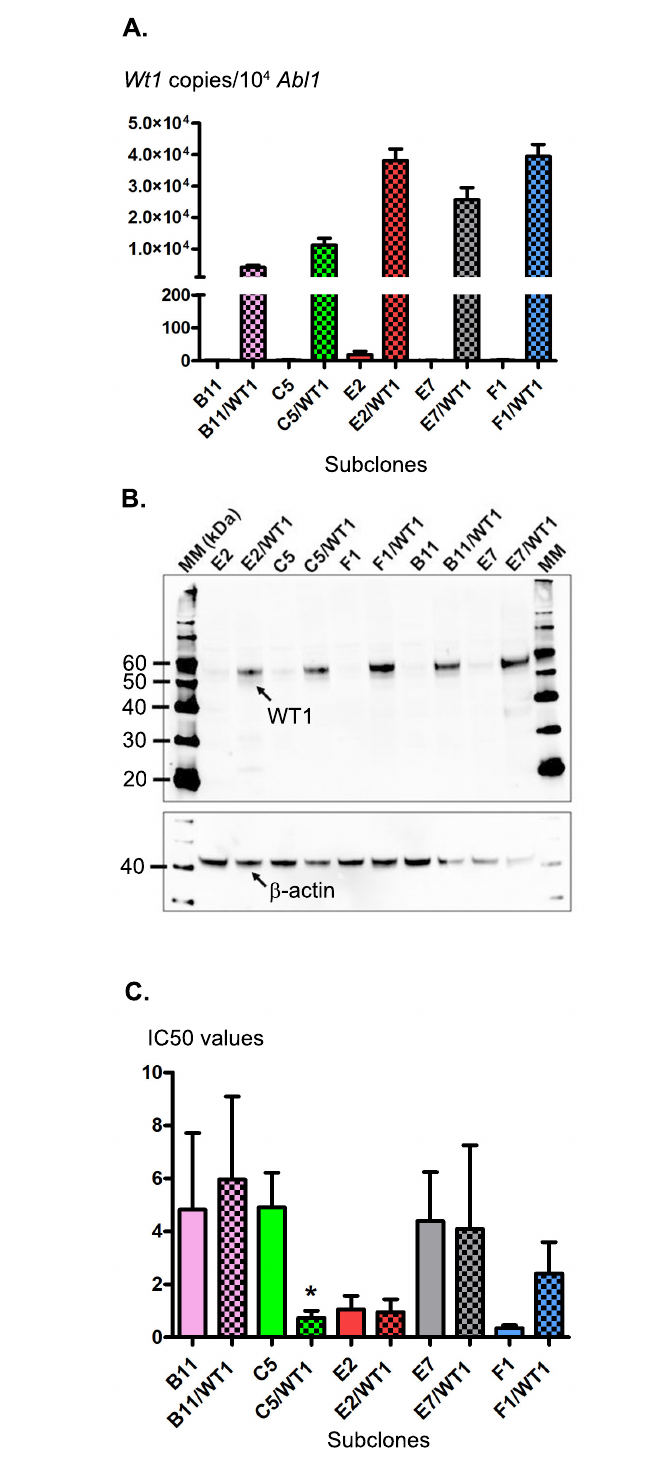
Fig 2. WT1 protein expression in different subclones. Different subclones were stably transfected with the pVITRO.1/Wt1 plasmid, and WT1 gene and protein expression levels were confirmed by RT-qPCR (A) and western blot (B), respectively. The subclones’ sensitivity to cytarabine treatment in vitro was also assessed and visualized using IC50 values for comparison with their respective untransfected subclones (C). For qPCR and survival assays, the mean ± SEM from three independent experiments are